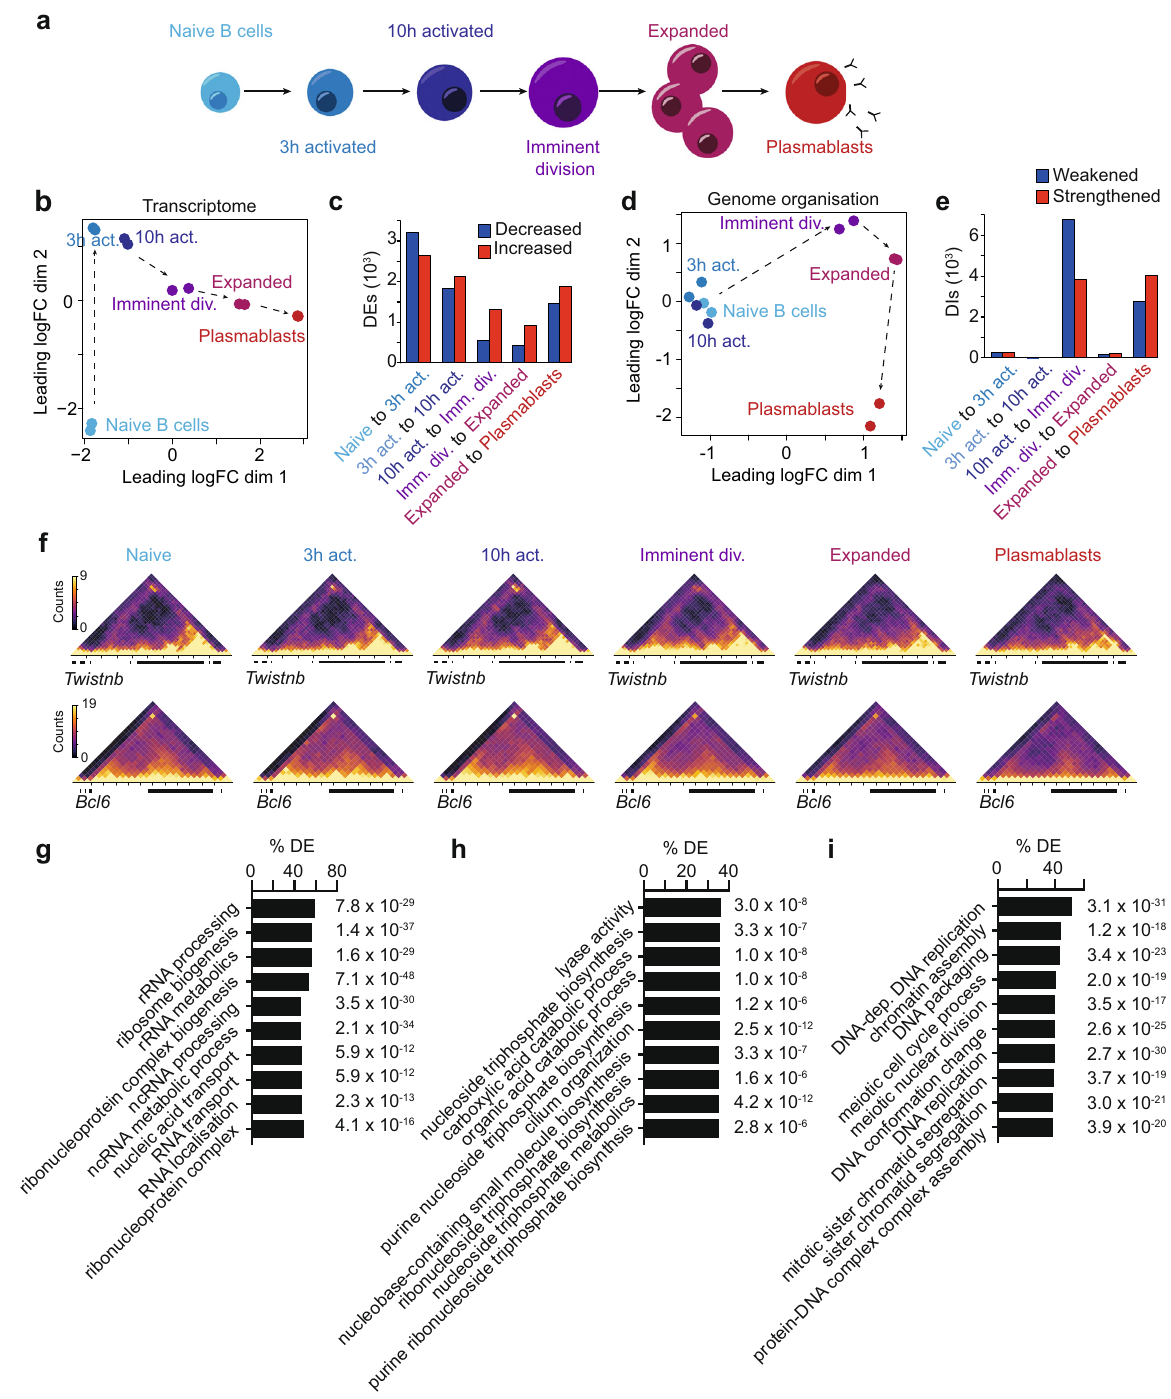
Fig. 1 Waves of genome reorganization bookend plasmablast differentiation. a Stages of B-cell activation and differentiation. b Multidimensional-scaling plot of RNA-seq data of B-cell activation. c Numbers of differentially expressed genes between B-cell activation stages calculated with fold changes signi fi cantly above 1.5 (Treat FDR < 0.05). Blue indicates a decrease in expression level with activation. Red indicates an increase in expression level with activation. d Multidimensional-scaling plot of B-cell activation demonstrating two dominant waves of genome organizational change. e Numbers of differential interactions (DIs) between B-cell activation stages. Blue indicates the weakening of organization with activation. Red indicates strengthening of organization with activation. f Normalized in situ HiC contact matrices at 50 kbp showing genome organization at the Twistnb (chr12:33.2 – 35.3 Mb) and Bcl6 (chr16:23.85 – 25.15 Mb) loci at each stage of B-cell activation. Color scale indicates the number of reads per bin pair. g Gene ontological terms with genes increasing in differential expression between the naive and 3 h activated B cells over-represented. Groups ranked according to the percentage of groups genes that are differentially expressed. h Gene ontological terms with genes increasing in differential expression between the 3 and 10 h activated B cells over-represented. Groups ranked according to the percentage of genes that are differentially expressed. i Gene ontological terms with genes increasing in differential expression between the 10 h activated B cells and those imminently to divide over-represented. Groups ranked according to the percentage of groups genes that are differentially expressed. Source data are provided as a Source Data fi